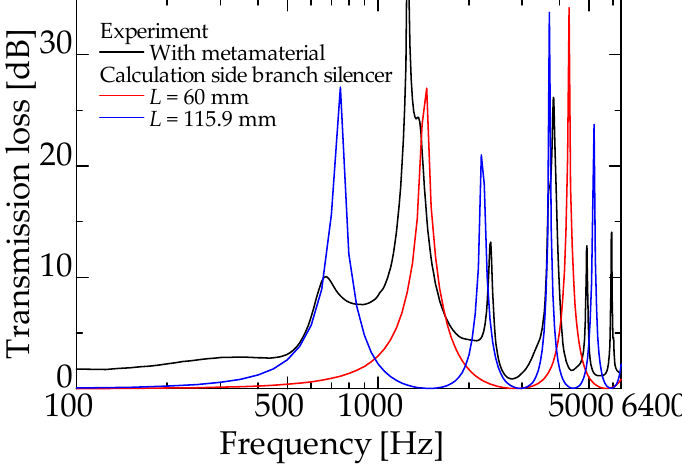
Figure 14. Comparison with simple side-branch silencer (experimental: interference silencer with zero-mass metamaterial; theoretical: side-branch silencer with 60 mm and 115.9 mm branch tube length).